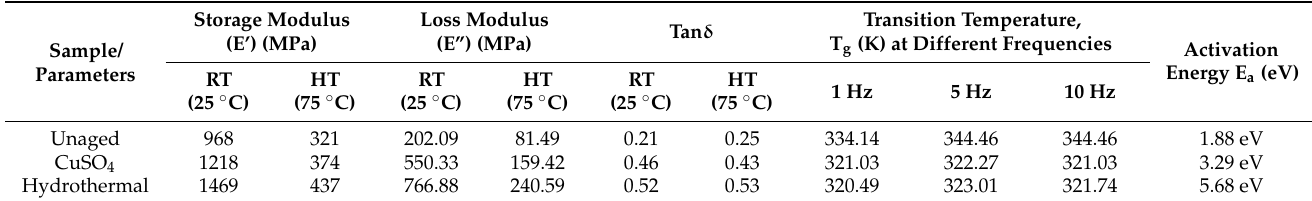
Table 3. Mechanical loss factor and storage modulus of various XLPE